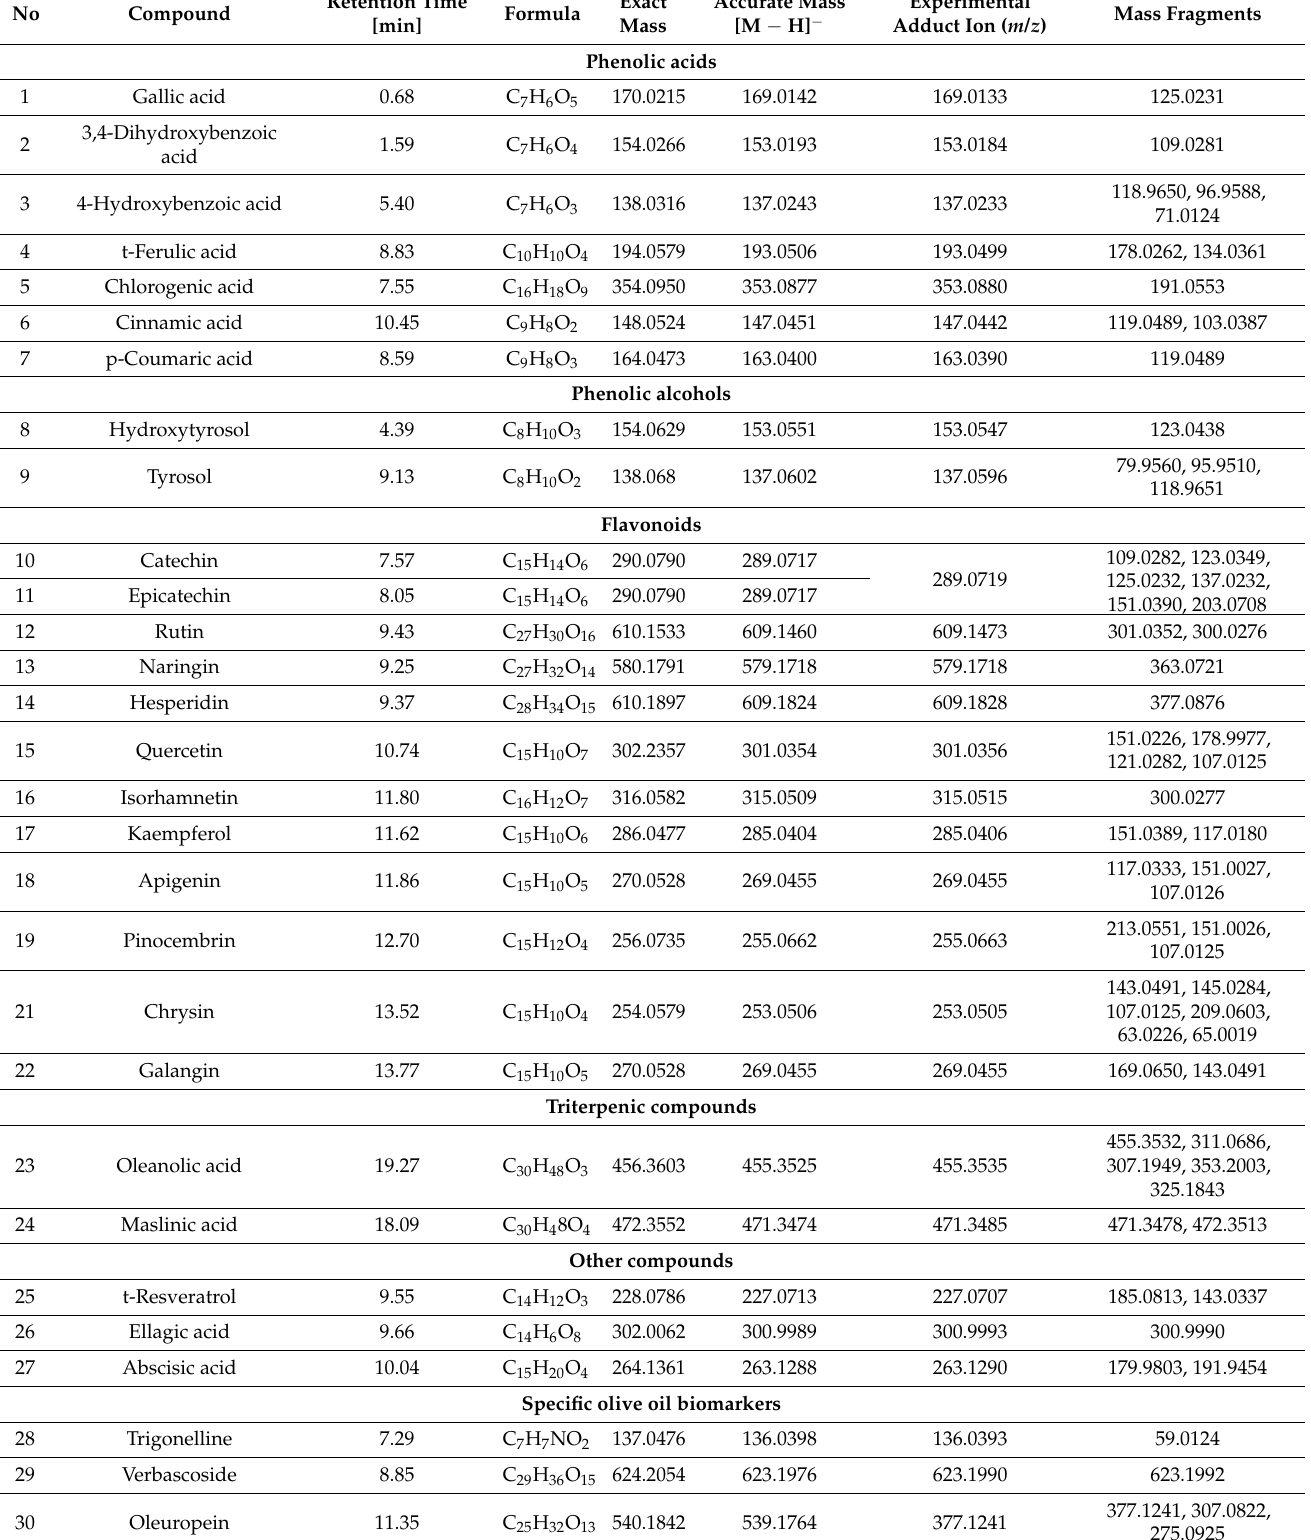
Table 1. The identification of minor and major phenolic compounds and triterpenic compounds in vegetable oils using UHPLC-HRMS with structures confirmed by comparison with reference